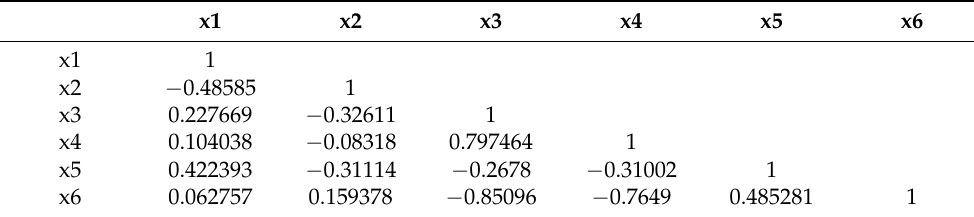
Table 3. Correlation matrix, compiled by the authors of the study.